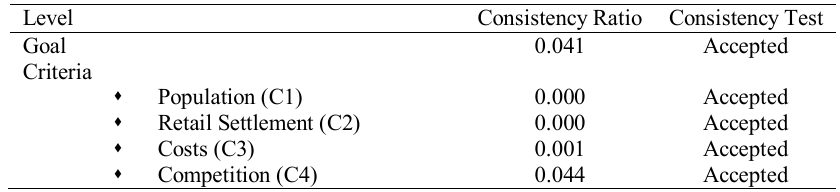
Table 3: Consistency test for location selection goal, criteria and attributes